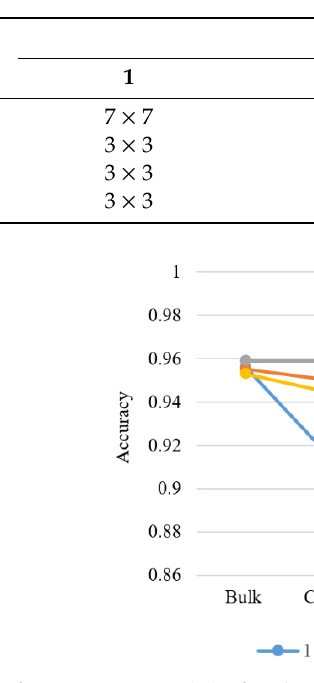
Table 1. Combination of di ff erent convolution kernels.